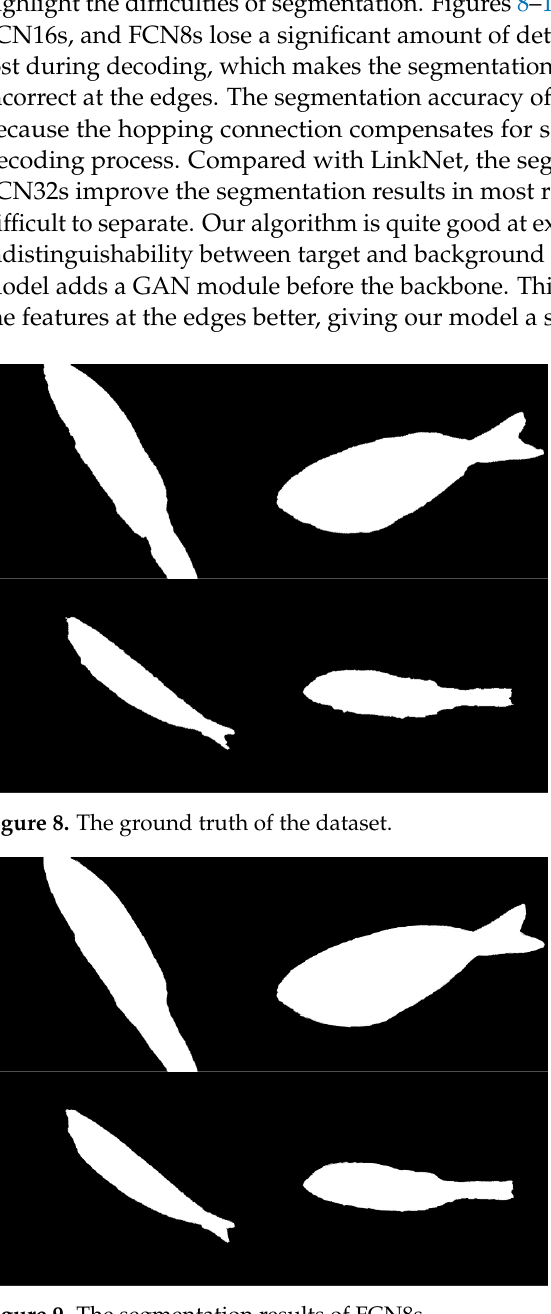
Figure 9. The segmentation results of